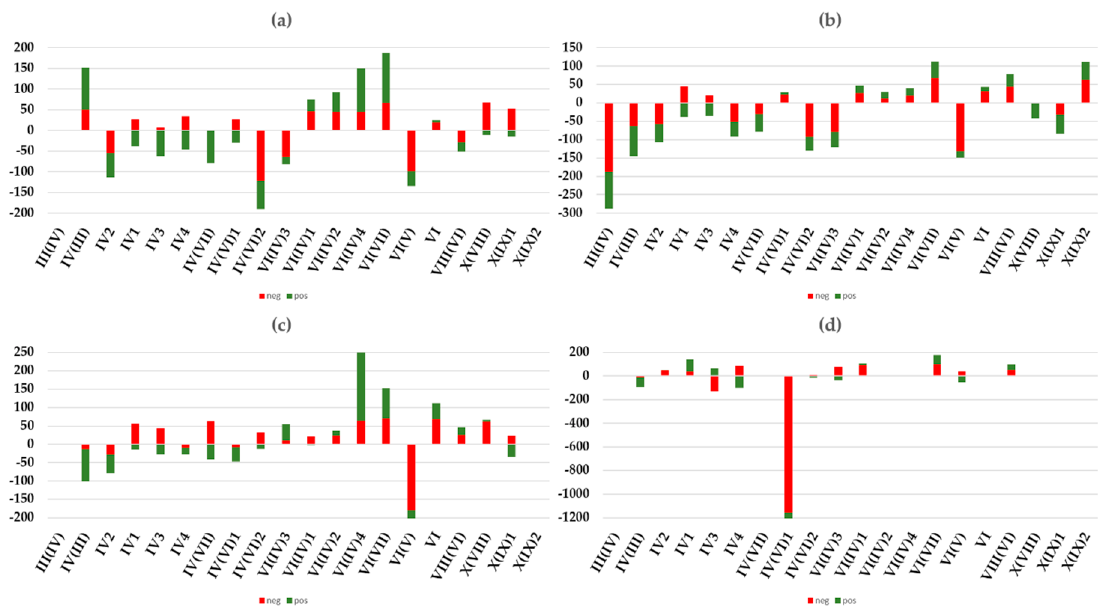
Figure 9. Difference in percentage ( y -axis) between the observed and expected NDVI negative (in red color) and positive (in green color) short-term trend pixels from our study area, by phytoclimatic type, within the 311 ( a ), the 312 ( b ), the 313 ( c ), and the 321 ( d ) CORINE Land-Cover classes.